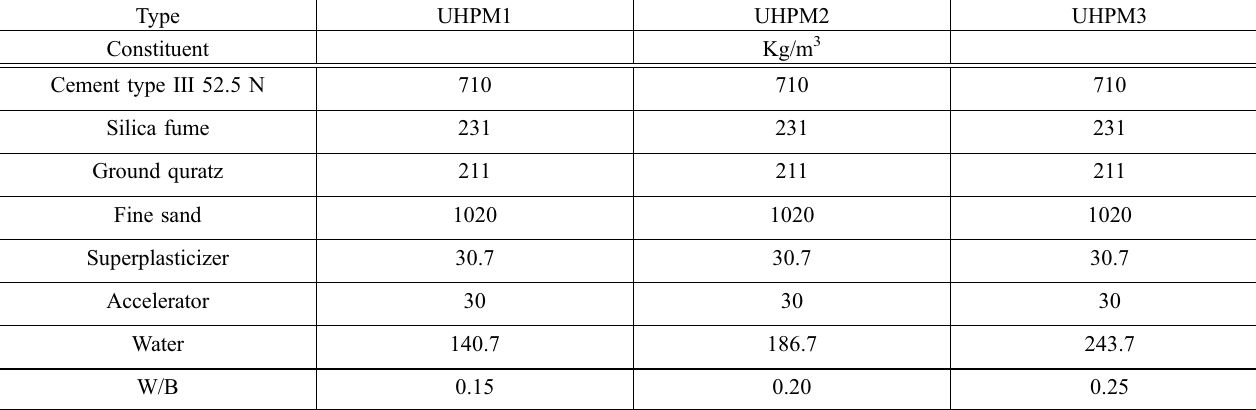
Table 1 Constituents and proportions of ultra-high performance mortars (kg/m 3